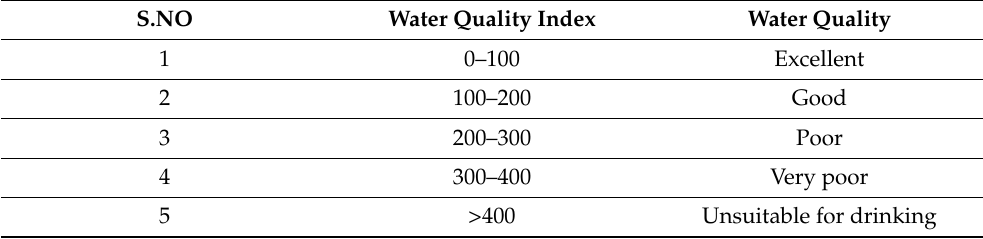
Table 3. Water Quality Index (WQI)